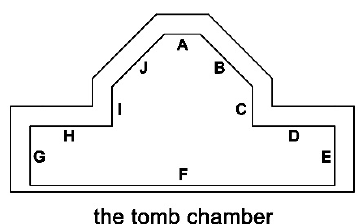
Figure 21. Position of simulation segments.